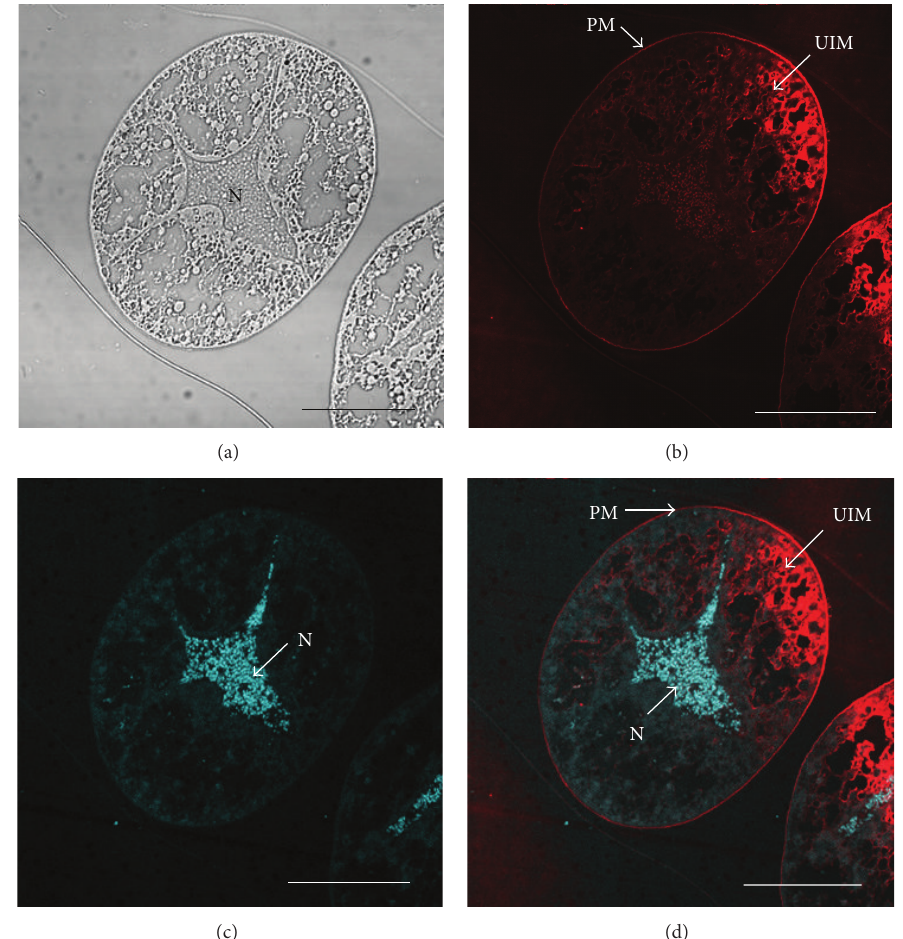
Figure 3: Semithin sections of teratocytes were dual-stained with Dil for plasma membrane and with TO-Pro3 for nucleus. (a) Transmitted light micrograph of teratocyte showing internal structure of the cell. (b) Same cell section stained with Dil showing strong staining of plasma membrane and an unidentified internal membranous network. (c) Same section stained with TO-Pro3 showing intense staining of chromosomal DNA within the large amorphous nucleus. (d) Overlaid images from (a) to (c) showing red plasma membrane and blue amorphous nucleus. N: nucleus, PM: plasma membrane, UIM: unidentified internal plasma membrane network. Scale bars = 20 𝜇